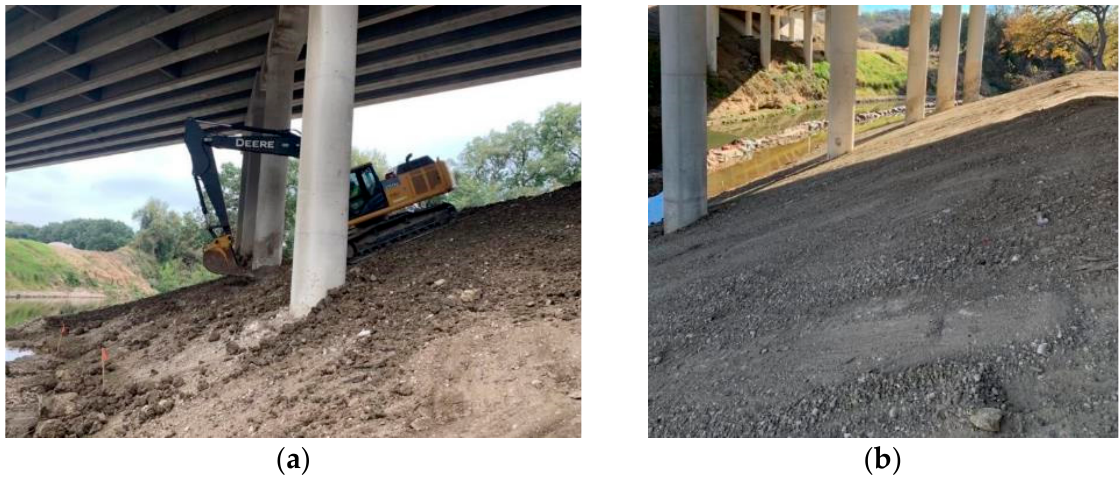
Figure 4. Slope grading work on the west bank used for this study: ( a ) slope work to proposed configuration; ( b ) finished graded slope.